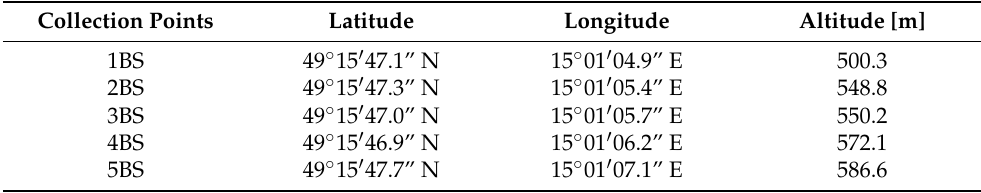
Table A1. GPS locations of individual burn points.